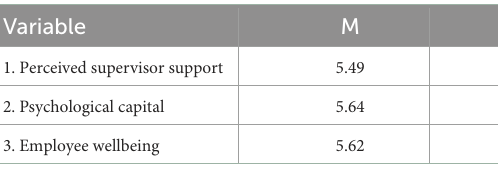
TABLE 2A Correlational analysis.